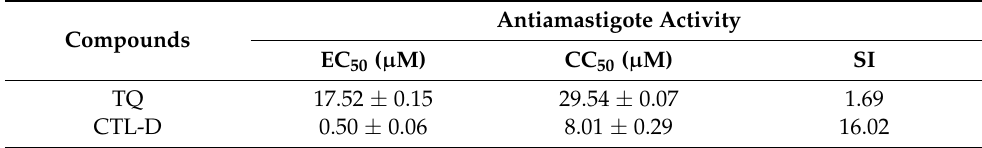
Table 2. Antiamastigote activity of TQ and